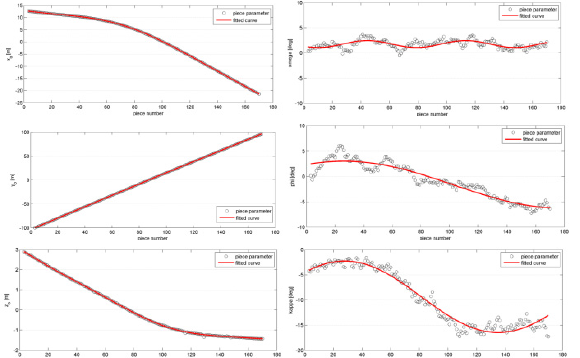
Figure 12. Distances between final model and railway points for dataset 1 (top) and 2